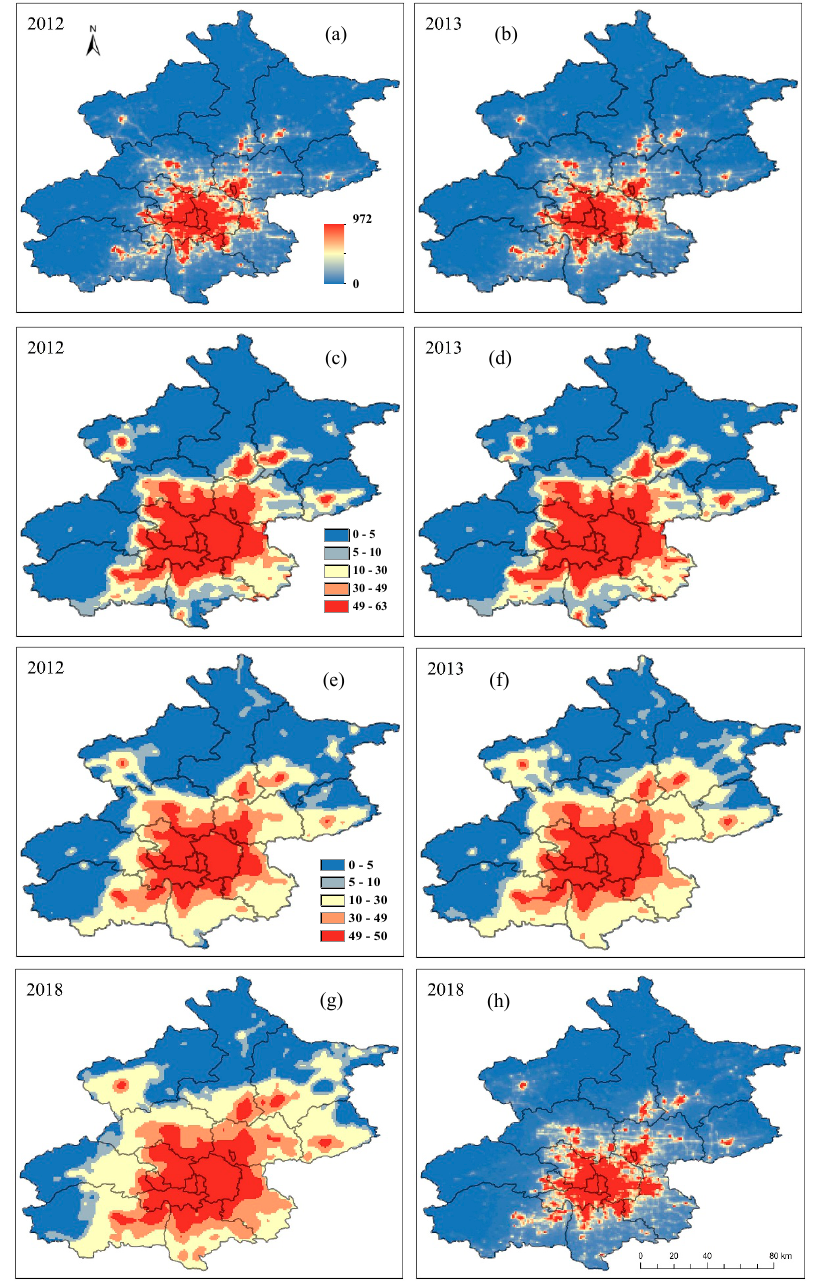
Figure 9. VIIRS, calibrated DMSP and simulated DMSP annual composites in Beijing. VIIRS annual composites in 2012 ( a ), 2013 ( b ) and 2018 ( h ); calibrated DMSP annual composites in 2012 ( c ) and 2013 ( d ) and simulated DMSP annual composites in 2012 ( e ), 2013 ( f ) and 2018 ( g